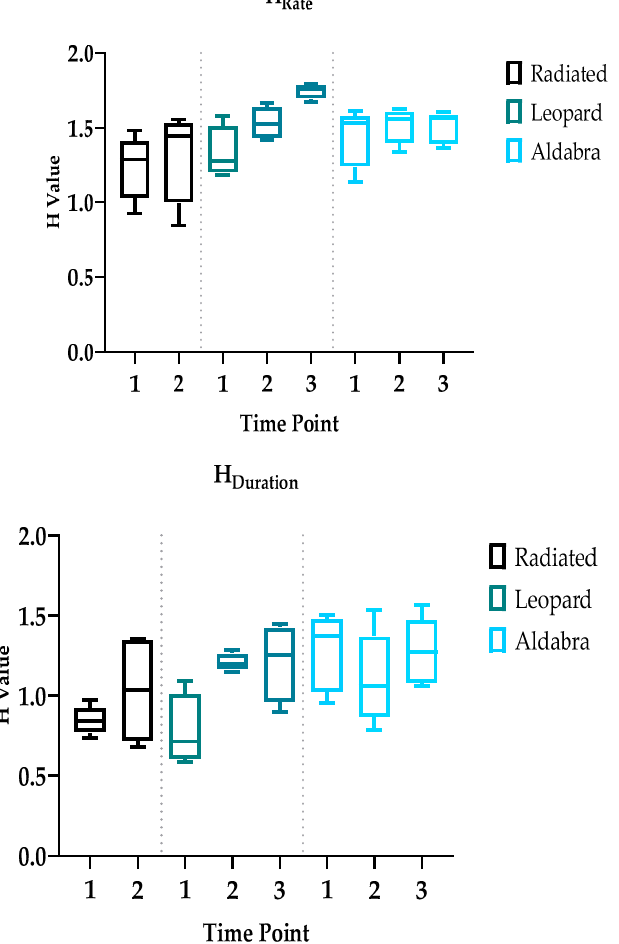
Figure 6. Diversity index box plots for H Rate ( top ) and H Duration ( bottom ) separated by species over time (1) Before environmental change, (2) 10–21 days post-change, (3) 230–250 days post-change. Due to additional husbandry changes subsequent to the second time point, there was no third time point for radiated tortoises.